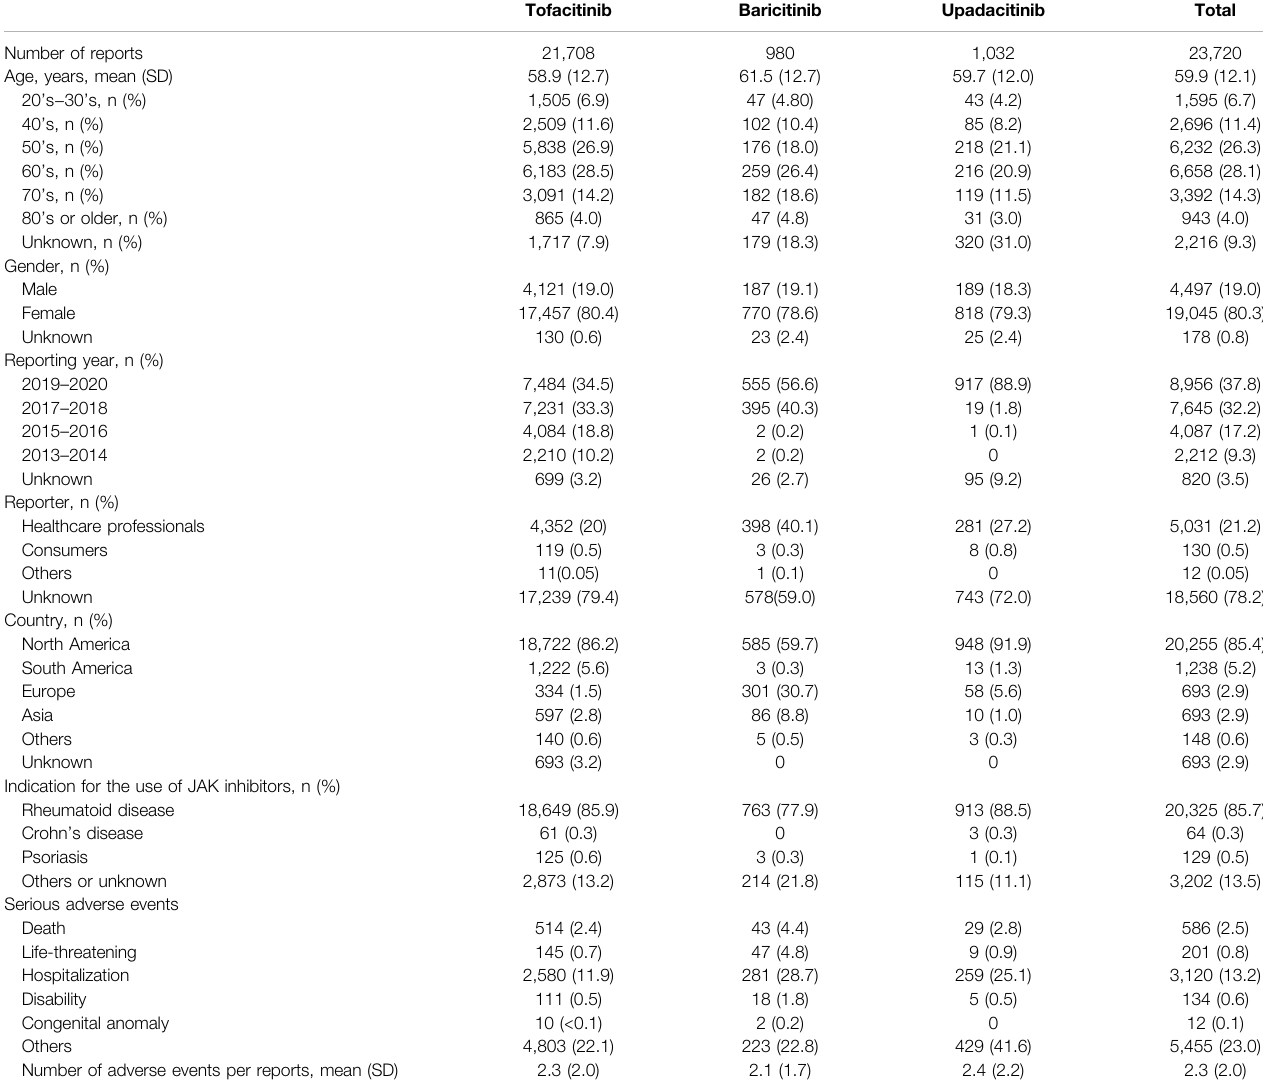
TABLE 1 | Demographic characteristics of population who reported adverse events of JAK inhibitors in the FAERS